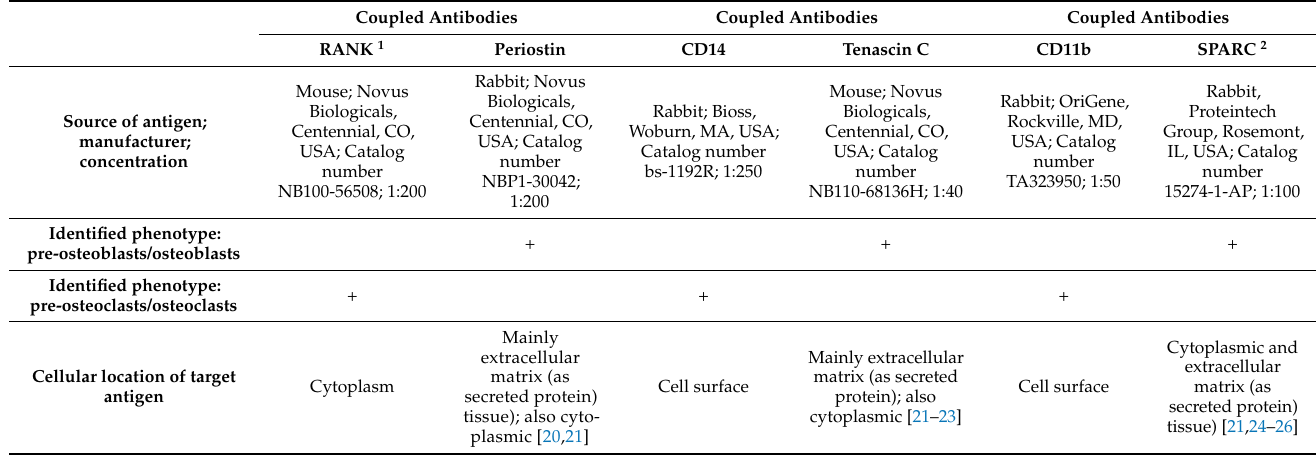
Table 1. Antibodies used for the immunomorphometric assessment of pre-osteoblast/osteoblast and pre-osteoclast/ osteoclast cell